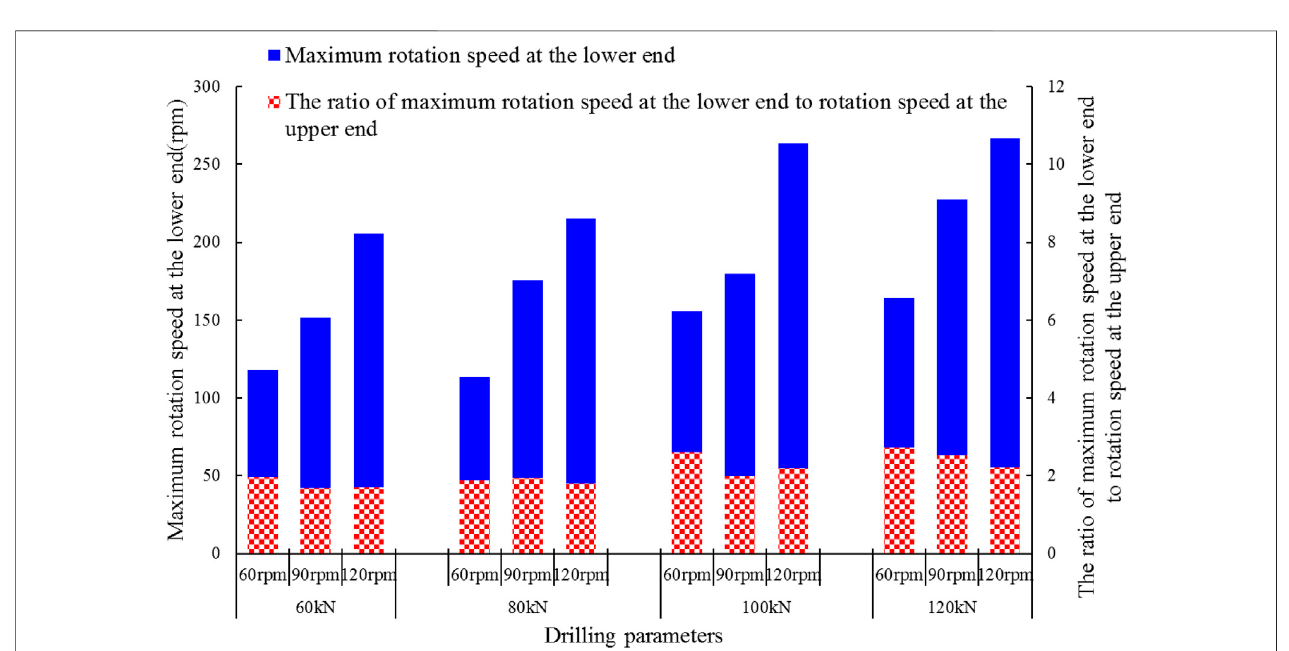
FIGURE 7 | Maximum rotation speed at lower end of drill string and the ratio of maximum rotation speed at lower end and rotation speed at upper end.